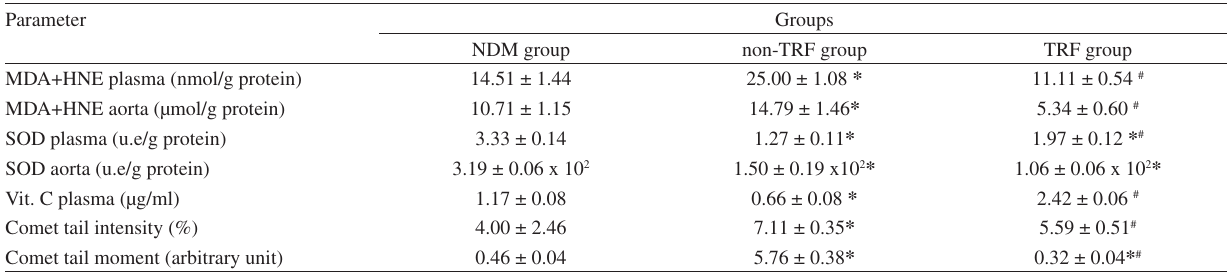
Table 2 - MDA+HNE and SOD in plasma and aorta, plasma vitamin C levels and DNA damage in peripheral lymphocytes in NDM, non-TRF and TRF groups following eight weeks of study